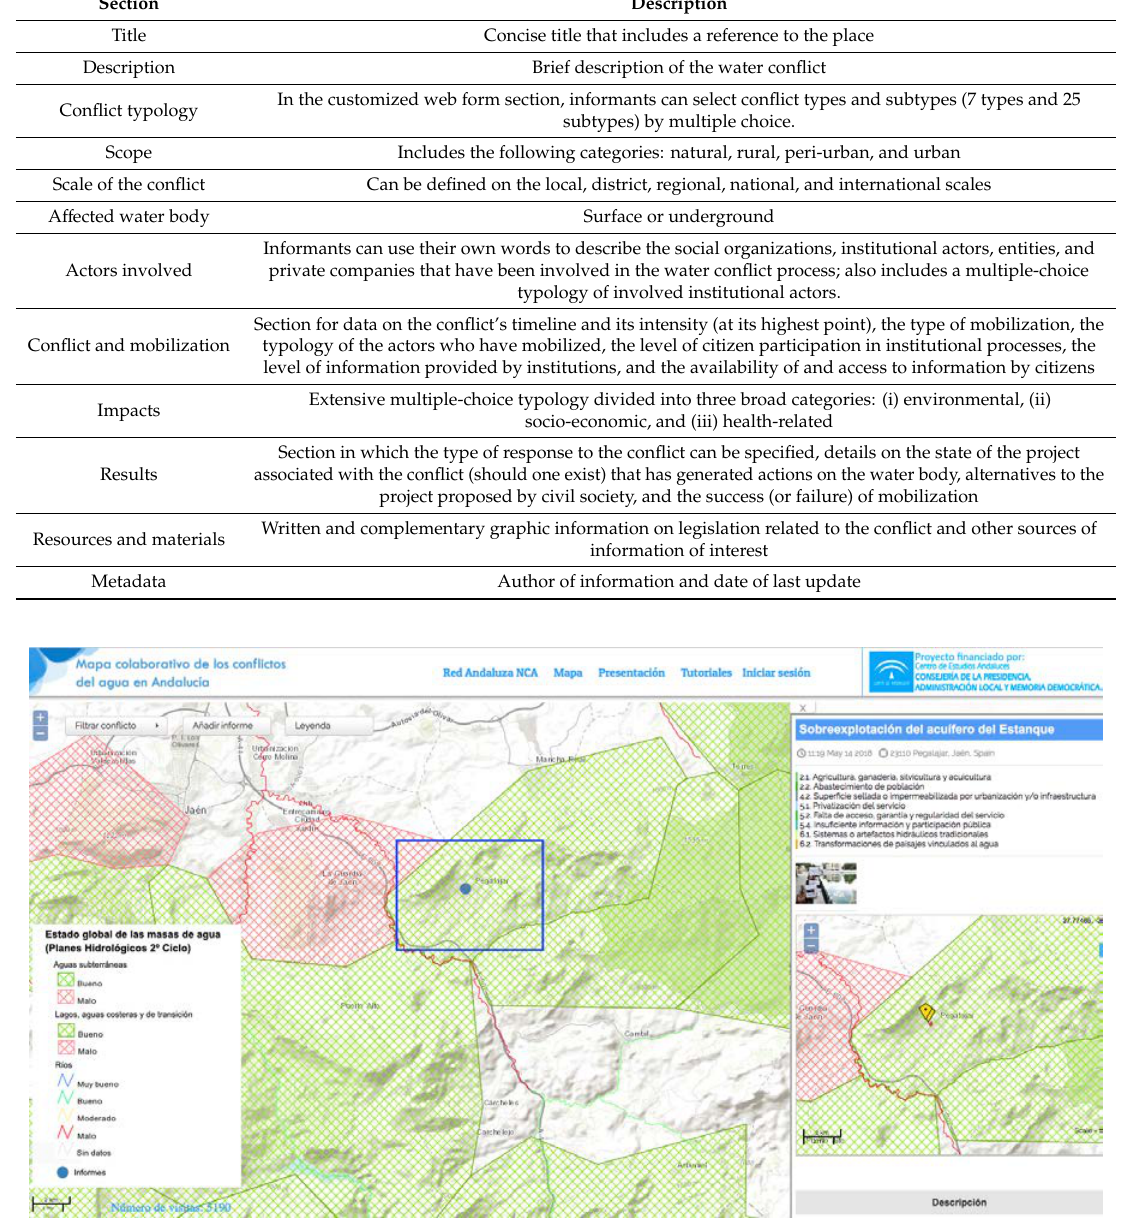
Figure 6. One of the conflicts (overexploitation of Estanque aquifer, Pegalajar) overlaid on the official characterization of water bodies. Source: Map-RedNCA https://redandaluzaagua.org/mapa/, retrieved November 2019.